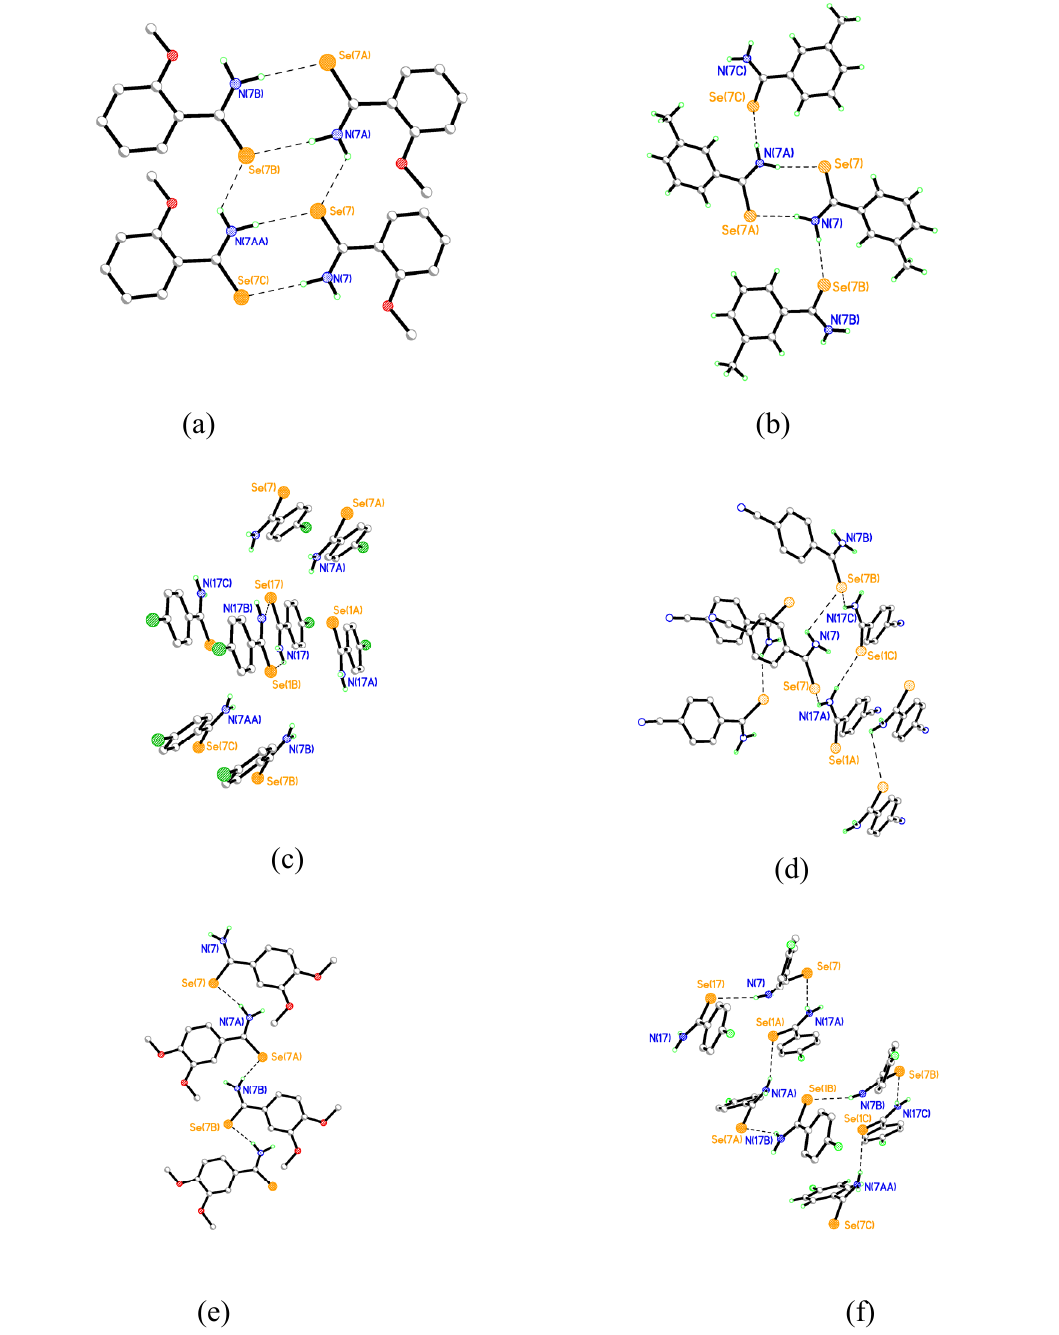
Figure 2. Examples of H-bonding motifs. (a) 1 ladder (b) 2 linked dimer (c) 7